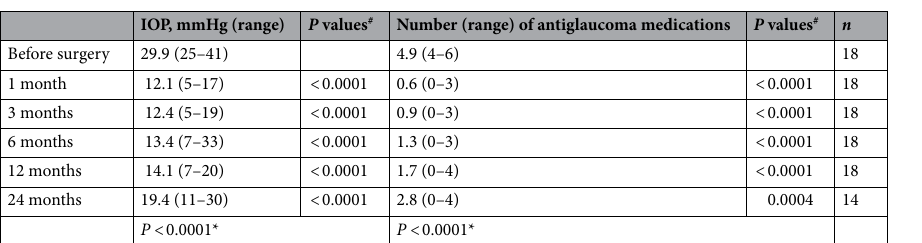
Figure 1. Survival analysis and comparison of glaucoma treatments. ( A ) Kaplan–Meier survival analysis of 18 eyes treated with suture trabeculotomy ab interno in all eyes. ( B ) Comparison of eyes with or without previous glaucoma surgery and/or vitrectomy. Treatment failure was defined as an intraocular pressure (IOP) value of ≥ 22 mmHg and a < 20% IOP reduction with or without medication on two consecutive visits, or as additional operations needed to reduce IOP. The small vertical dashes along the curves represent times of censored observations.